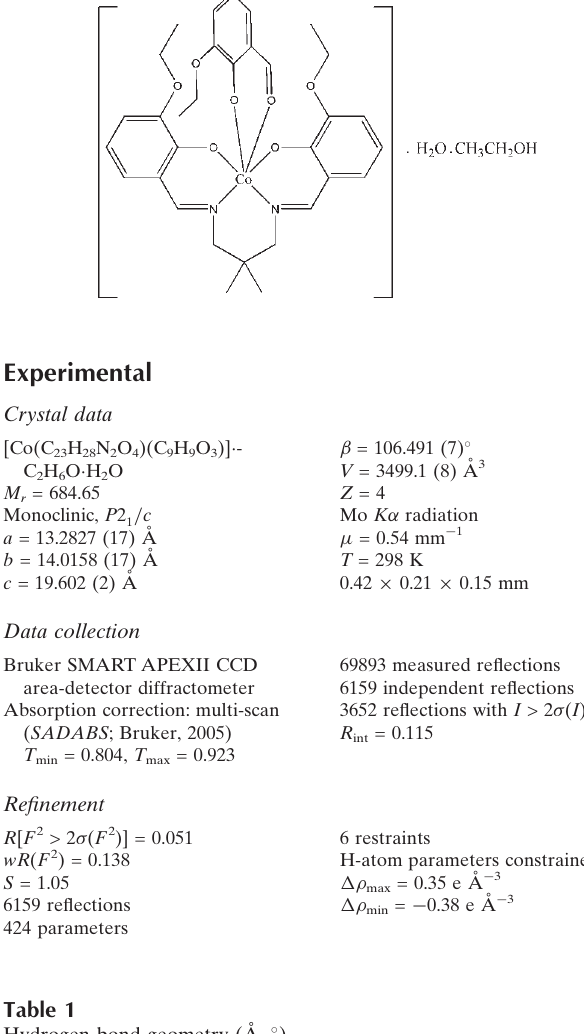
Hydrogen-bond geometry (A˚ , (cid:3)